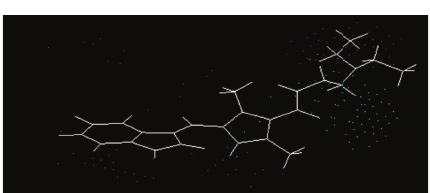
Figure 6: The electrostatic potential master grid with compound 4. Red: positive charge is favoured in this region or negative charge is disfavoured in this region. Blue: negative charge is favoured in this region or positive charge is disfavoured in this